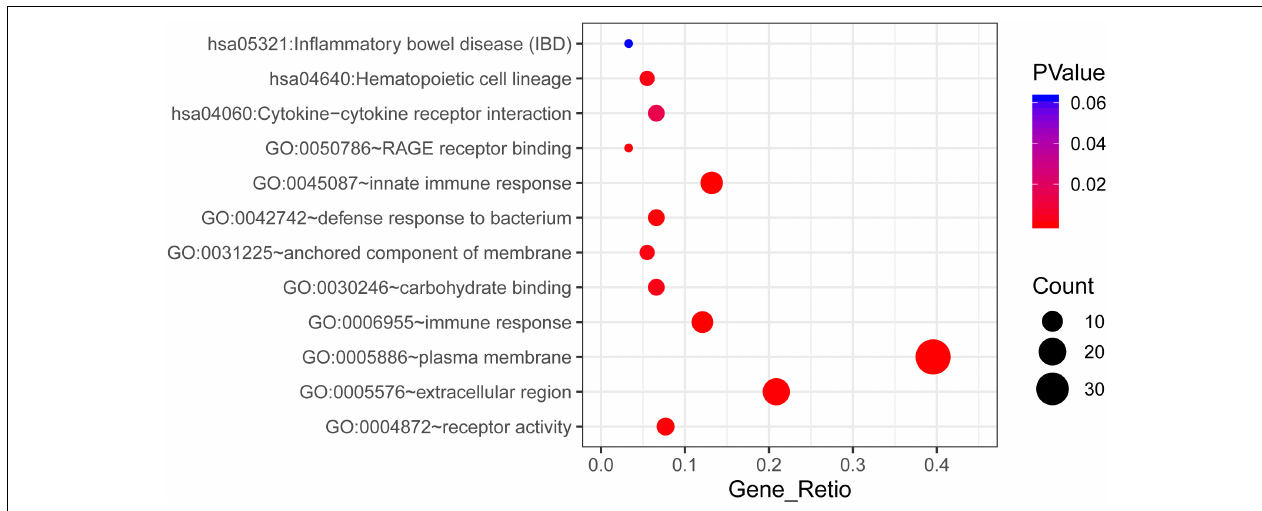
FIGURE 2 | The KEGG pathway and GO enrichment analysis of DEGs in STEMI. The color depth of nodes refers to the corrected P -value of ontologies. The size of nodes refers to the numbers of genes that are involved in the ontologies. P < 0.01 was considered statistically significant.